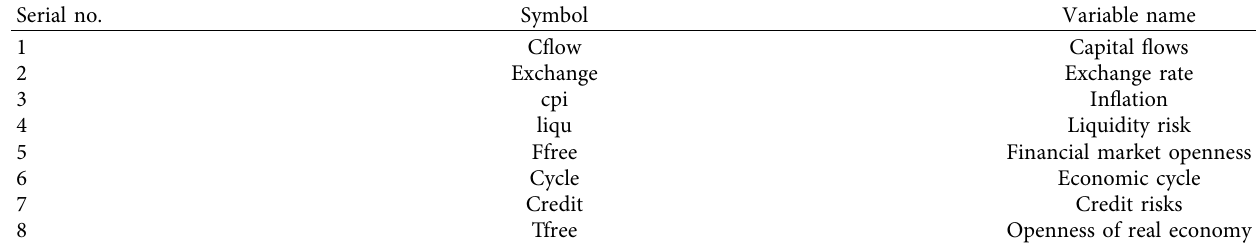
Figure 8: Gravitational space dynamic correlation coefcients. Table 4: Explanatory variable symbols and their defnitions.